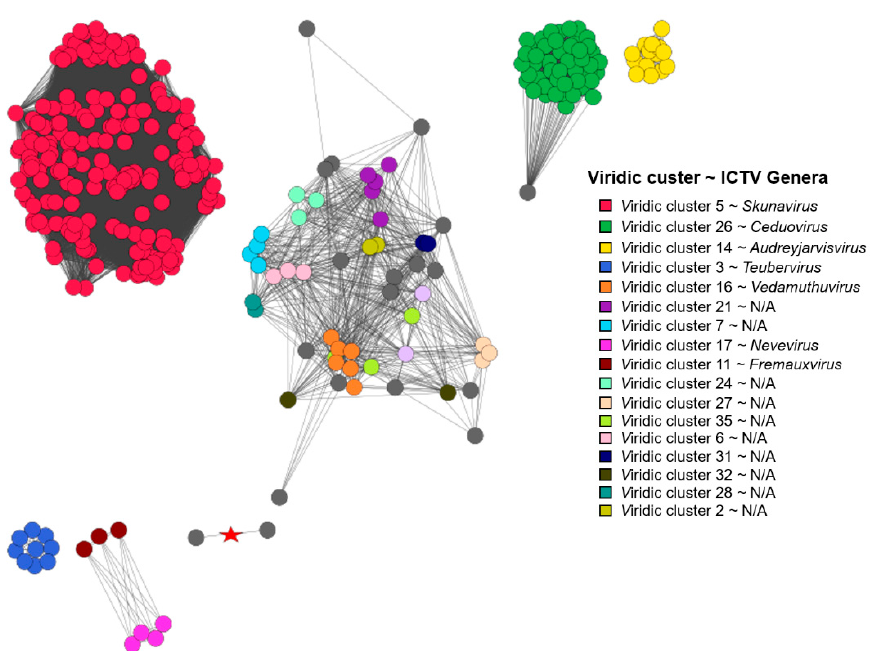
Figure 4. vConTACT2 protein sharing network of 347 Lactococcus phages (phages KSY1 (DQ535032.1) and asccphi28 (EU438902.1) were determined to be singletons based on their proteome contents and are not depicted). Nodes are colored based on the VIRIDIC cluster assignment (corresponding to the 65% genome nucleotide sequence similarity) according to the legend. The edge connecting Nocturne116 and Q54 is annotated with a red star. Of note, as VIRIDIC cluster assignment was not performed for all the Skunavirus and Ceduovirus representatives, the respective red and green coloring was extended on the basis of taxonomical assignment seen in the respective genome entries.